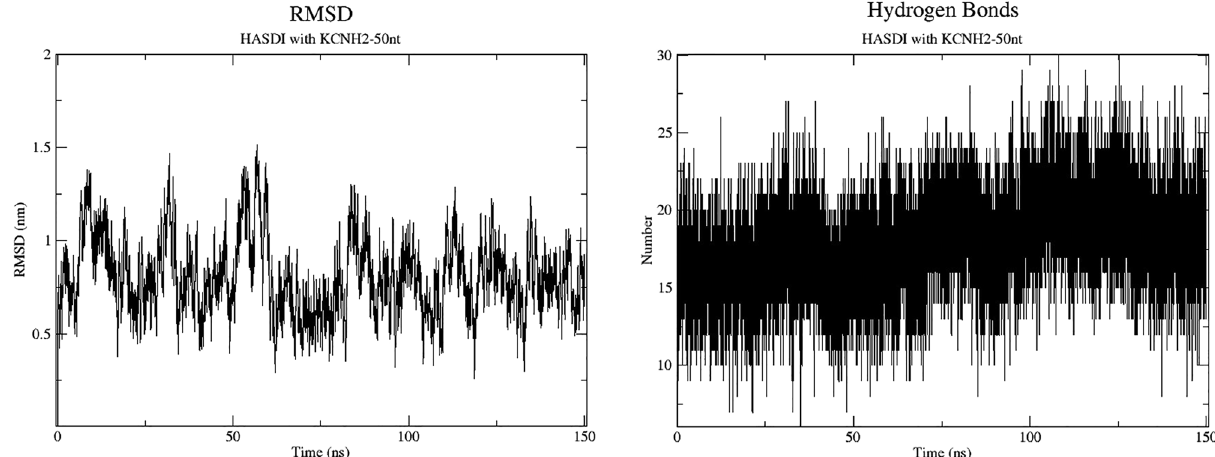
Figure 4. The root-mean-square deviation of HASDI in complex with KCNH2-50nt and the number of hydrogen bonds between it and the sequence 5 ′ -CGG GCG CTG GAG CGGC-3. The RMSD shows a significant level of amplitude of the oscillations, which become periodic towards the end of the simulation. During this period, their range varies within 6 Å. The number of hydrogen bonds also fluctuates with the simulation time and at first increases to 19 and then tends to decrease. Their average number ranges from 17 to